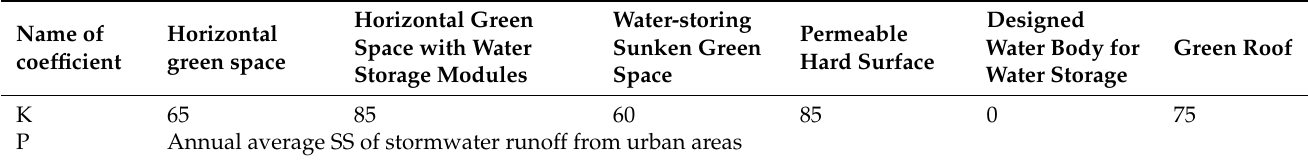
Table A4. Reference for runoff pollution removal capacity of different sponge